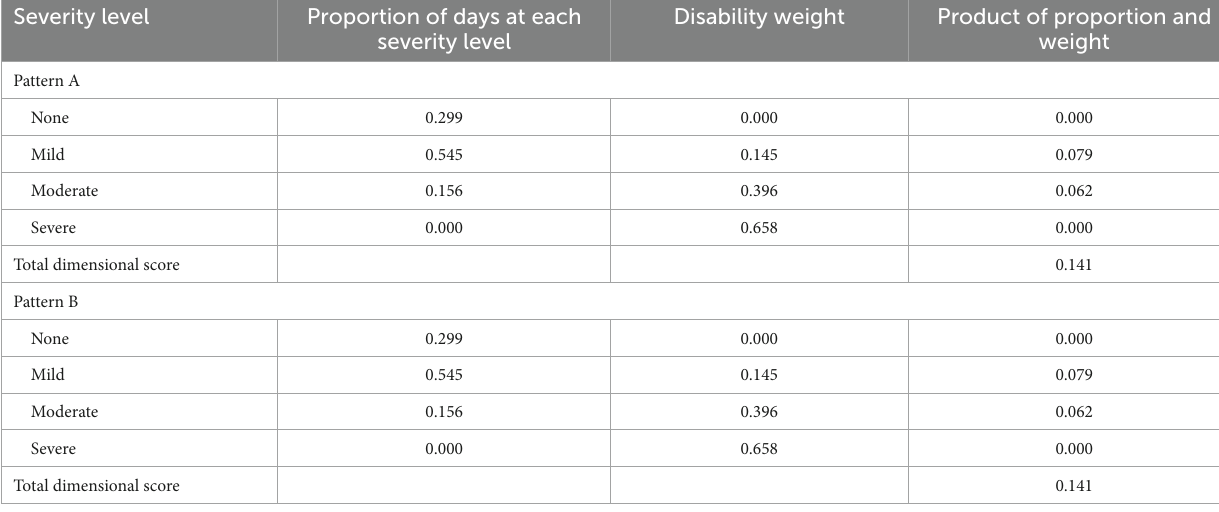
TABLE 2 Illustrative example of using health states and disability weights to construct a dimensional depression metric, data from Figure 5. Severity level Proportion of days at each Disability severity level